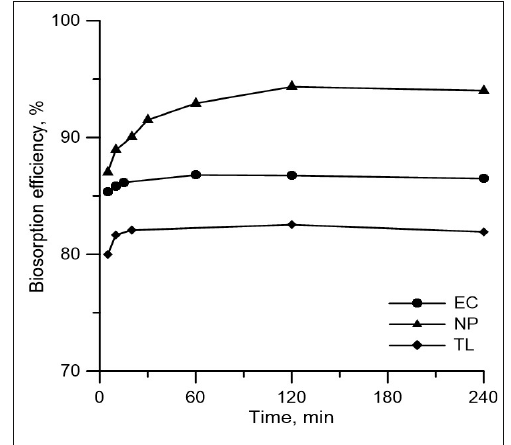
Fig. 6. Biosorption kinetic